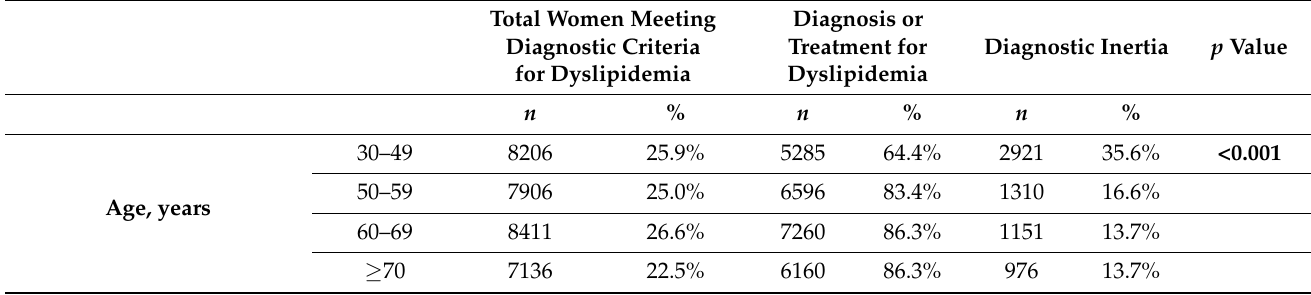
Table 3. Prevalence of diagnostic inertia in men, according to physical and analytical